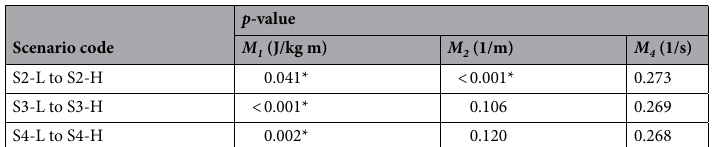
Table 3. The statistical parameters of the habitat hydraulic complexity metrics in the detailed measurement zone. M 1 is the kinetic energy gradient metric, M 2 is the normalized kinetic energy gradient metric, and M 4 is the modified recirculation metric. Min minimum, Max maximum, SD standard deviation.